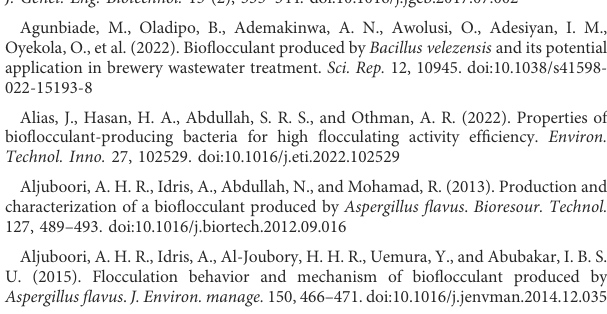
SUPPLEMENTARY FIGURE S1 The 16S rRNA gene sequence of C. glutamicum Cg1-P30. SUPPLEMENTARY FIGURE S2 Neighborhood joining tree of C. glutamicum Cg1-P30. SUPPLEMENTARY FIGURE S3 SEM micrograph images of puri fi ed bio fl occulant (A), Kaolin (B) and bio fl occulant aggregation with Kaolin